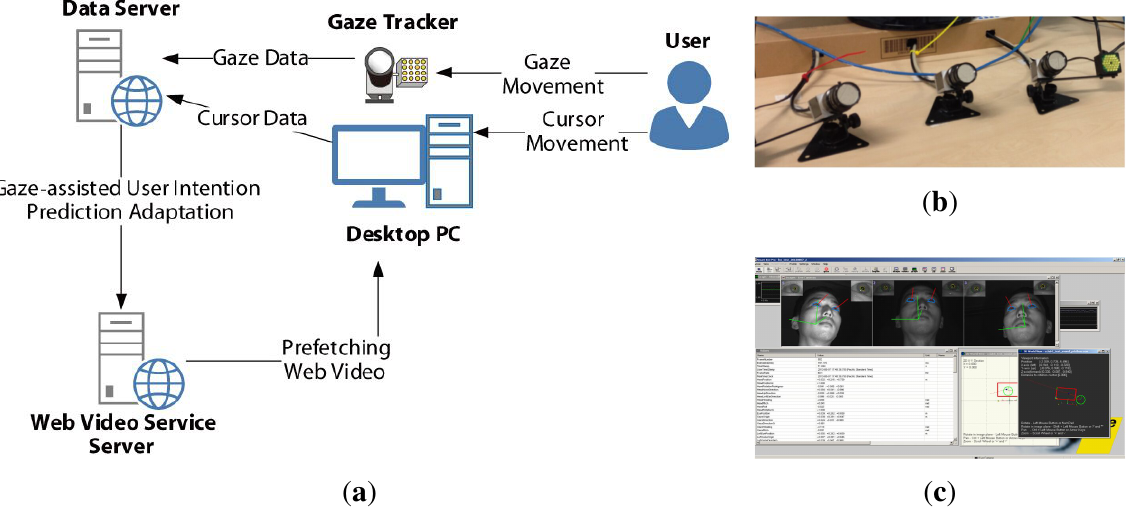
Figure 7. Test environment of the proposed gaze-assisted user intention prediction. ( a ) Framework of the implemented test system; ( b ) gaze trackers; ( c ) SmartEye Pro gaze tracking